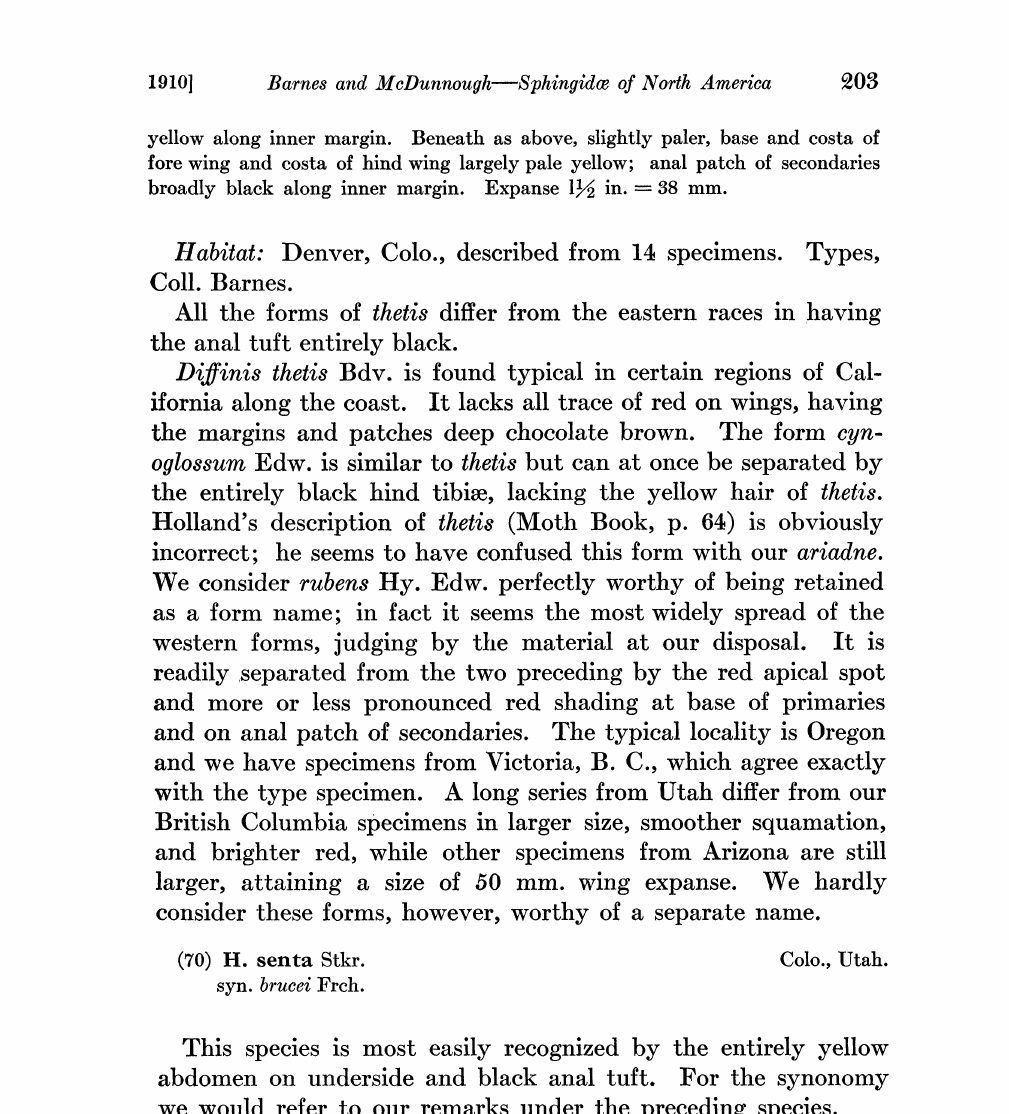
yellow along inner margin. Beneath as above, slightly paler, base and costa of fore wing and costa of hind wing largely pale yellow; anal patch of secondaries broadly black along inner margin. Expanse l/ in.--38